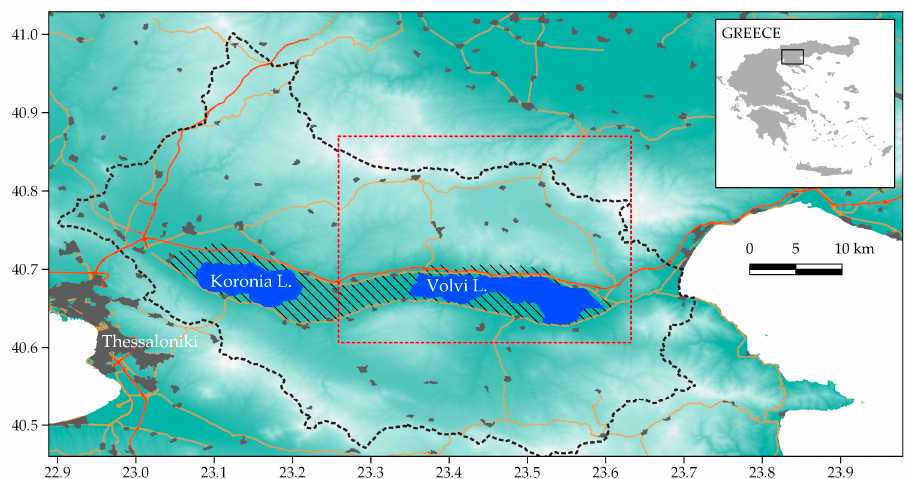
Figure 2. Map depicting the boundary of the Koronia-Volvi lakes National Park (dotted black line) and core zone (dashed area; Natura 2000 area GR1220001). Wildcat trapping was conducted near the southern banks of Lake Volvi, within the core area. [Grey areas mark urban areas incl. the metropolitan area of Thessaloniki, red lines motorways, orange lines primary and secondary two-way roads, and red dotted polygon the area within which the collared wildcats moved during the study period].